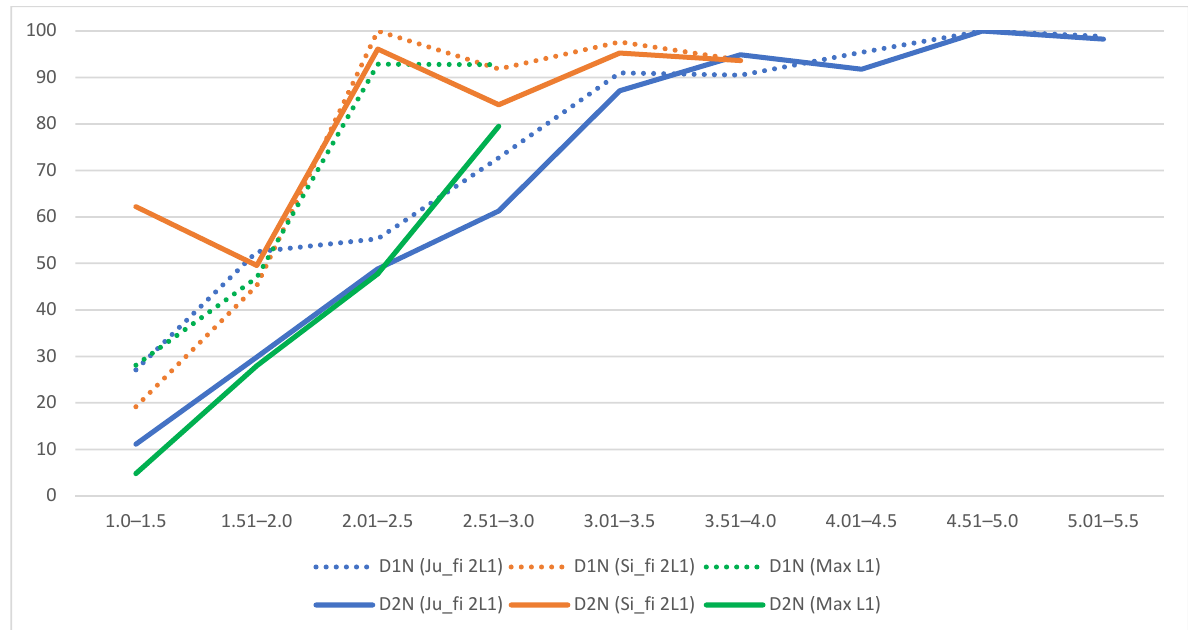
Figure 5. D realizations according to MLU—bilingual children vs. monolingual child (%). Both Max and Ju_fi are comparable to each other in that D1N are acquired with a greater accuracy than D2N. In general, Max seems to acquire D more target ‐ like than Ju_fi, especially in the D1N context from MLU 2.0 onwards, whereas for Ju_fi, the mean accu ‐ racy of D1N is only at 55.3% and at 92.9% for Max although the difference for D1N is not significant ( p = 0.05744 overall; p = 0.86502 from MLU 2.0–3.0). A similar contrast is notice ‐ able for D2N, especially at 2.51 ‐ 3.0 with a mean percentage of 61.3% for Ju_fi and 79.5% for Max. In this case, the difference is significant in the data ( p = 0. 00758 overall). For D1N, Si_fi’s data are very much comparable to those of Max. Ultimately, she at ‐ tains 91.8% at MLU 2.5–3.0, largely corresponding to 92.8% in Tremblay’s (2006) study in